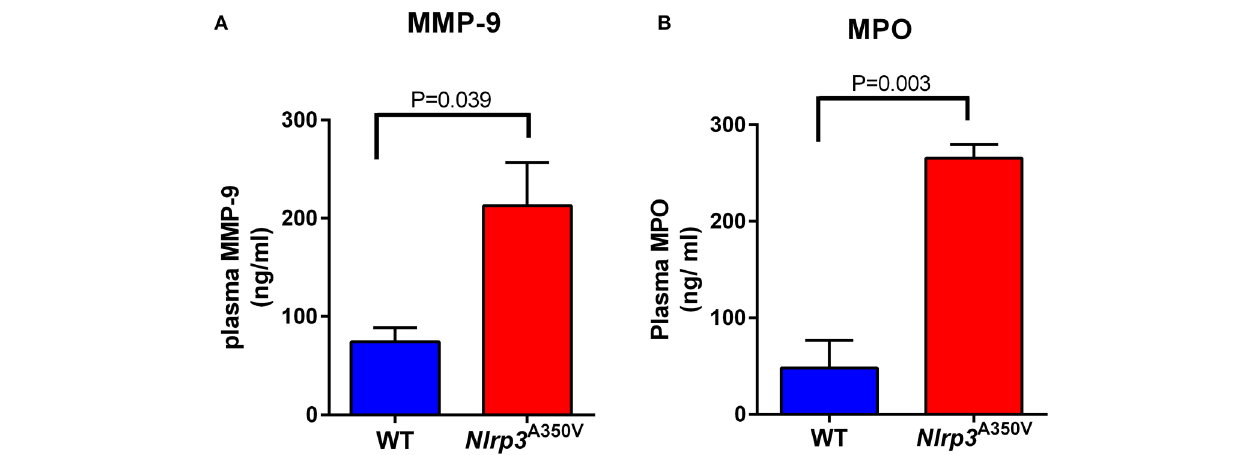
FIGURE 5 | The Nlrp3 A350V MWS mice show increased in vivo gelatinase and azurophilic granule exocytosis. The plasma levels of the gelatinase and azurophilic granule cargoes, gelatinase B (MMP-9) (A) and myeloperoxidase (MPO) (B) , respectively, were analyzed by ELISA in wild type (WT) and MWS (Nlrp3 mutant) mice as described under “Materials and Methods.” The data is presented as mean ± SEM and is representative of 3 independent experiments each with 3–5 mice per group. Significant differences between WT and mutant mice were calculated using unpaired Student’s t